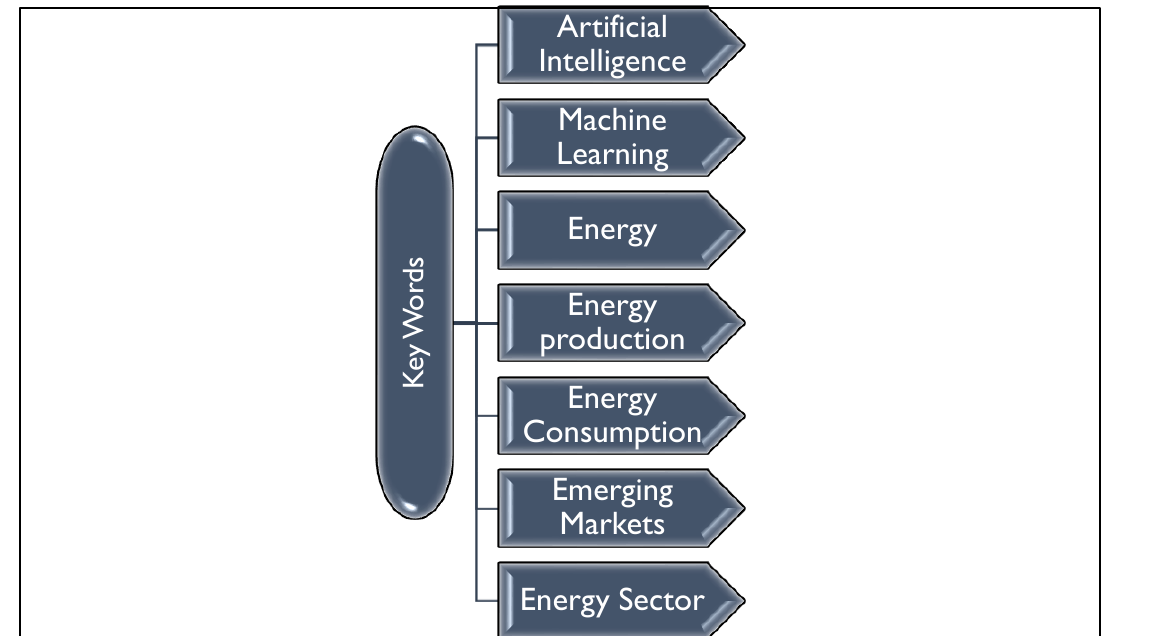
Figure 4. Keywords used in Systematic Literature review.